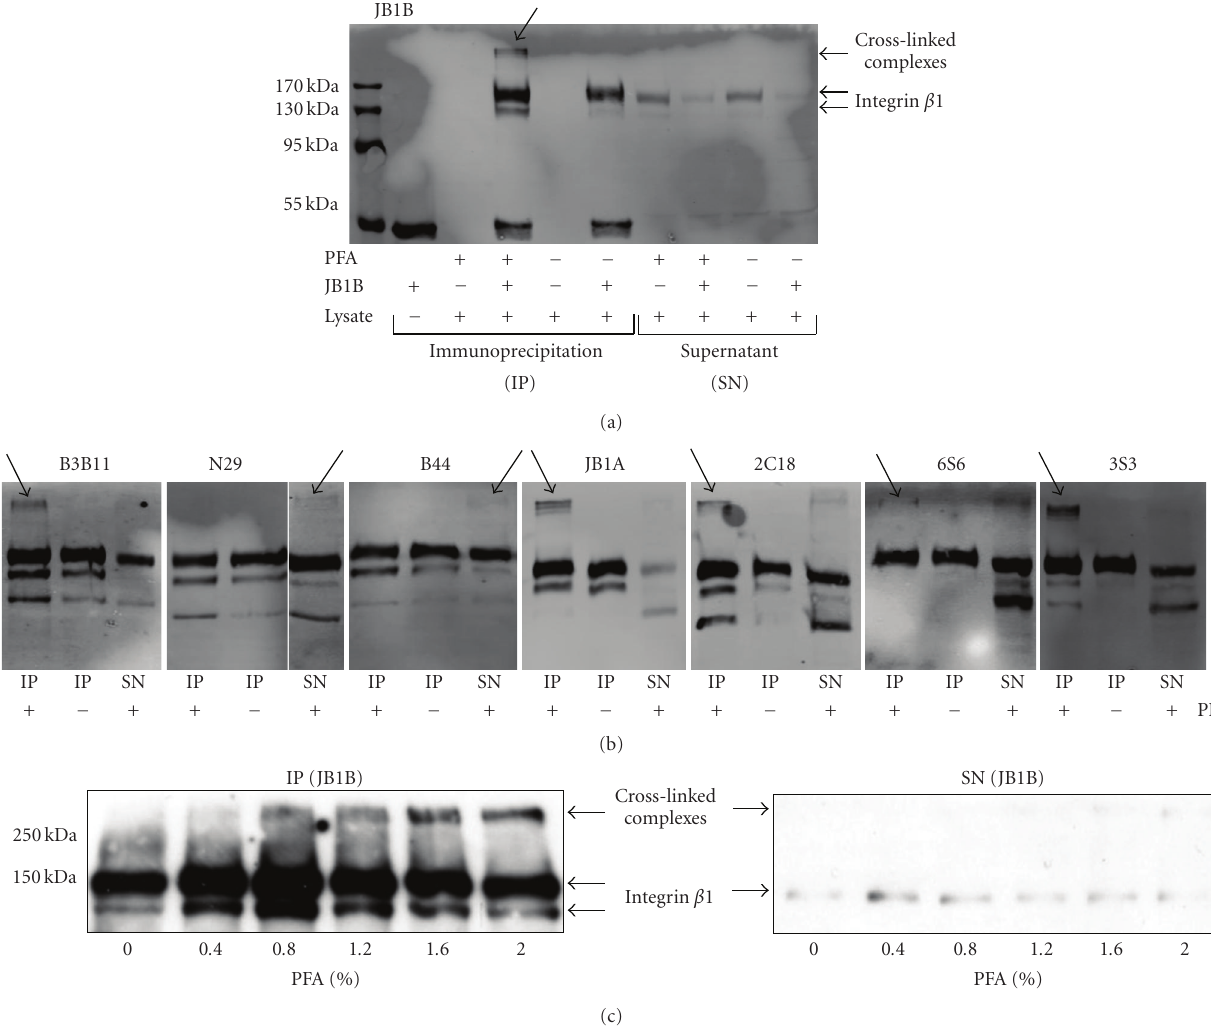
Figure 4: Precipitation of cross-linked integrin β 1 complexes. (a, b) Jurkat cells were treated with or without 0.4% formaldehyde (PFA) before lysis. Immunoprecipitation was performed using 0.5 mg of lysate and 1 μ g of the indicated antibody. Immunoprecipitations (IP) and supernatants (SN) were analyzed for presence of integrin β 1 complexes using JB1A for immunoblotting (anti-mouse Alexa Fluor 680). (a) JB1B precipitated the integrin β 1 complex (indicated by arrow) from formaldehyde treated cells. (b) Test of the remaining seven antibodies for precipitation of integrin β 1 from formaldehyde treated cells using the same parameters as in (a). (c) Jurkat cells were treated with di ff erent concentrations of formaldehyde (PFA) and lysed. 100 μ g lysate were used for pull-downs with JB1B (1 μ g) and immunoprecipitations (IP) and supernatants (SN) were analyzed by anti-integrin β 1 immunoblotting (JB1A, anti-mouse